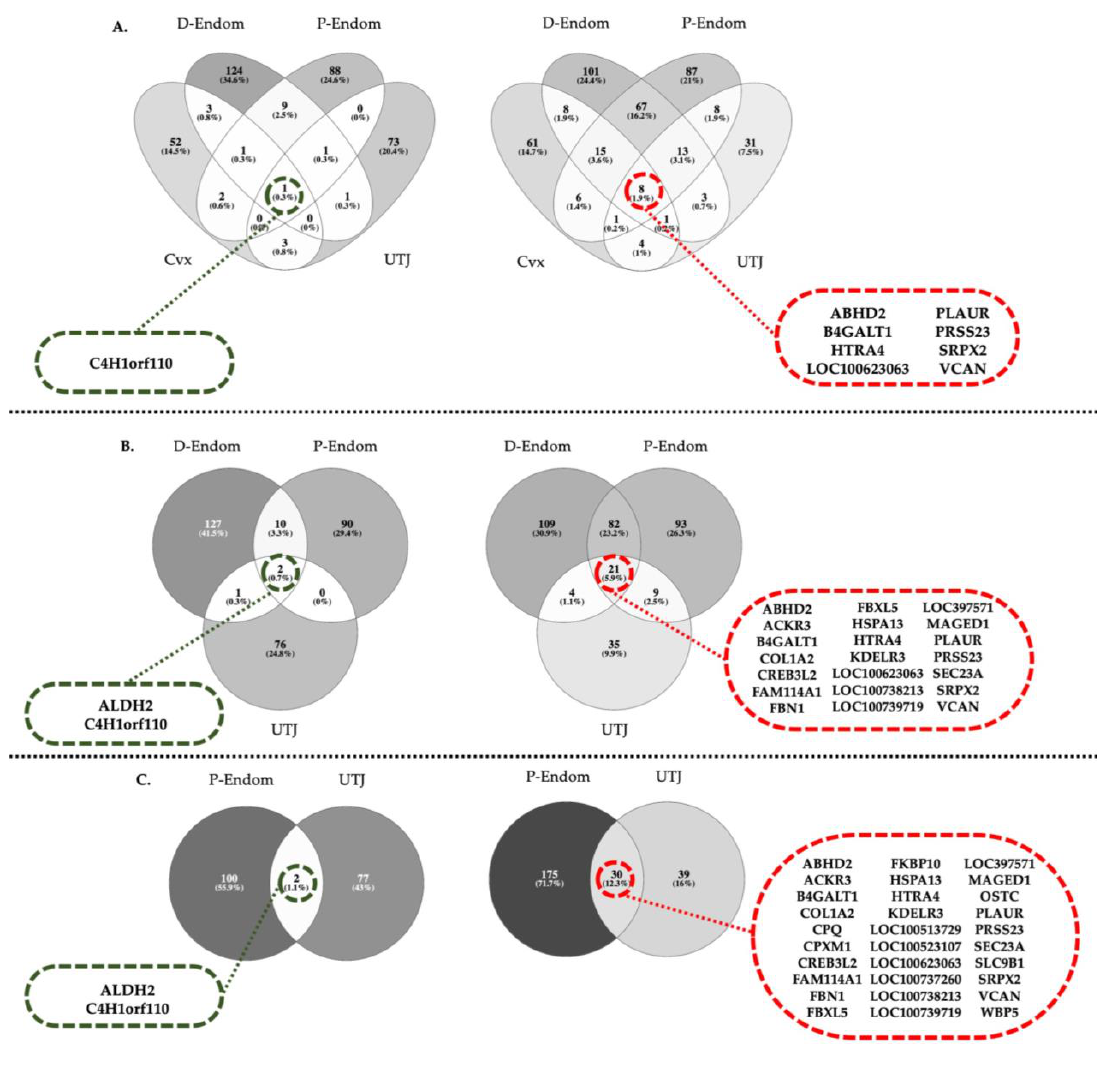
Figure 3. ( A – C ) Venn diagrams depicting in discontinuous rings the numbers and acronyms of copulation-induced, co-expressed DEGs shared by the different mucosal segments of the sow uterus (endocervix (Cvx), endometrium (distal: D-Endom or proximal: P-Endom) and the utero-tubal junction (UTJ), as listed in Supplementary Tables S1–S4. The diagrams include ( A ) comparisons of all four segments, ( B ) when endocervix was excluded or ( C ) when excluding endocervix and distal endometrium. Upregulated genes in green and downregulated in red.